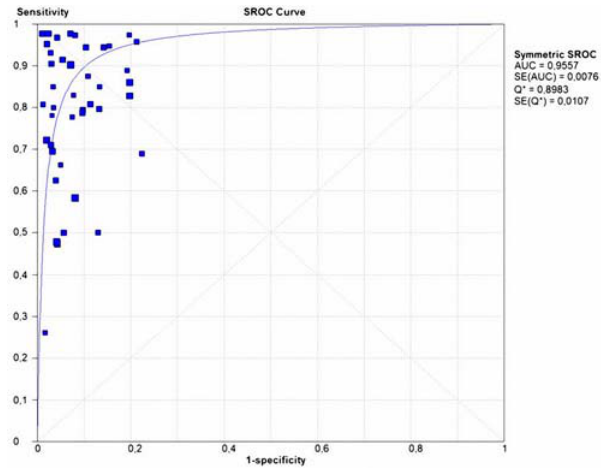
Figure 5. Summary Receiver Operator Curve (SROC) for Western Blot Diagnostic Tests. Each solid square represents an individual study in the meta-analysis. The curve is the regression line that summarizes the overall diagnostic accuracy. AUC=area under curve, SE (AUC)=standard error of AUC, Q*=index defined by point of the SROC curve where the sensitivity and specificity are equal; SE (Q*)=standard error of Q* index.